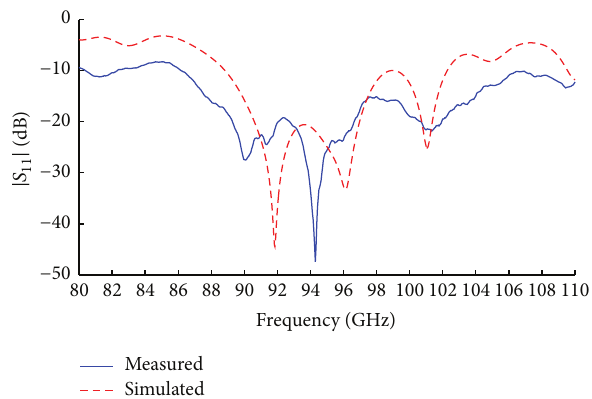
Figure 2: Measured and simulated reflection coefficient |𝑆 11 | versus frequency of the proposed Quasi-Yagi loop antenna prototype I.